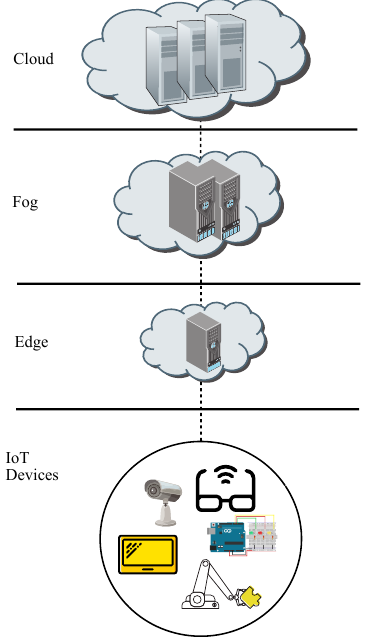
Figure 2. Layer hierarchy within the framework